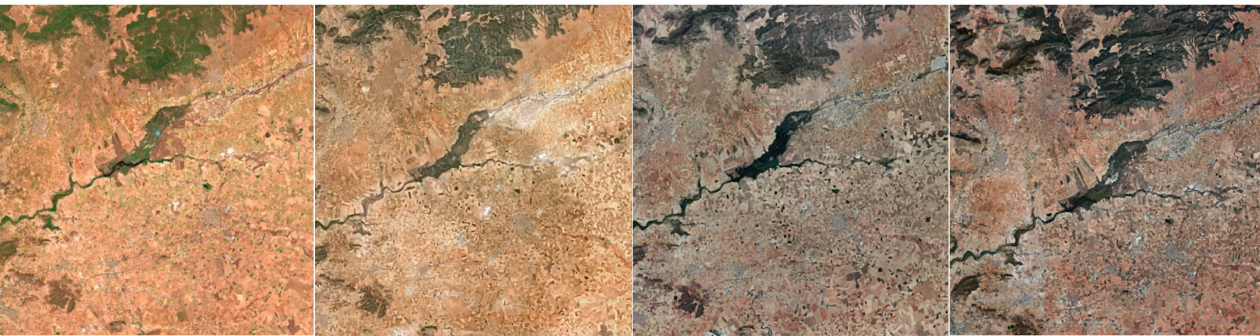
Figure 14. Sequences of satellite images of the area of study of the Tablas de Daimiel National Park for 2005, 2010, 2015 and 2020.